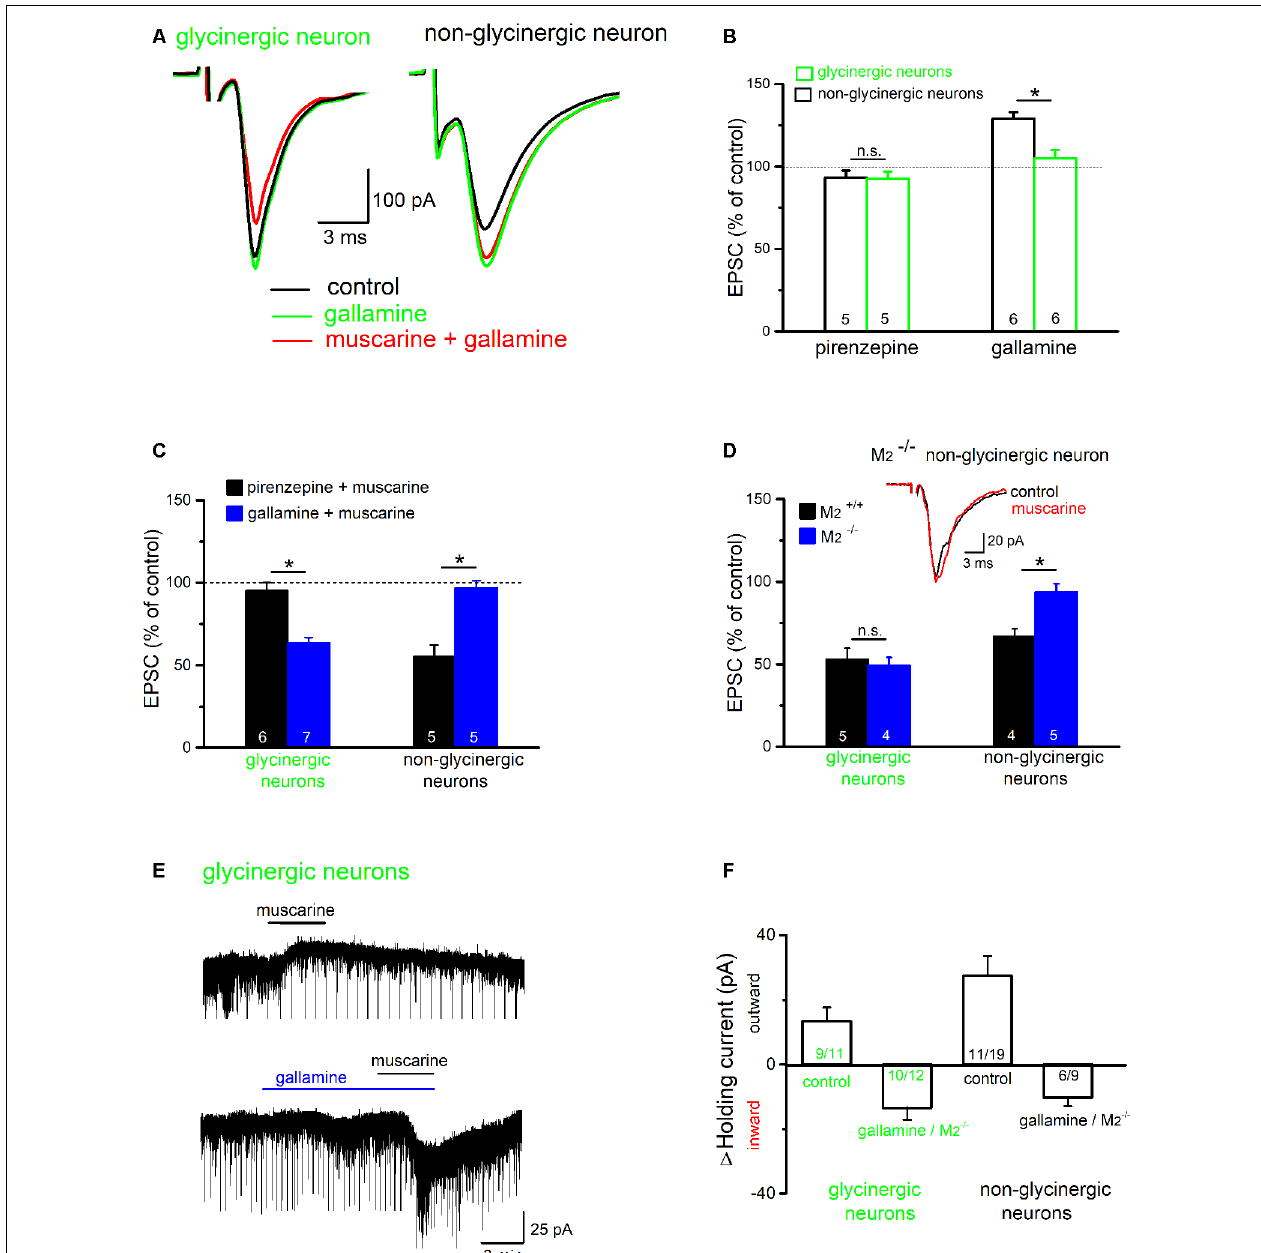
FIGURE 10 | Muscarine exerts a receptor subtype-specific control over excitatory synaptic input onto preBötC neurons. (A) Superimposed traces show the effects of the M 2 R blocker gallamine (20 µ M) on evoked EPSCs in representative traces from both groups of neurons. Gallamine increased EPSC amplitude and blocked the effect of muscarine (10 µ M) in the non-glycinergic neuron (right), but not in the glycinergic neuron (left). (B) Histogram summarizes the relative changes in EPSC amplitudes compared to control (amplitude of control EPSC was set to 100%) in response to the application of the M 1 R antagonist pirenzepine (1 µ M) or the M 2 R antagonist gallamine. Note that an endogenous M 2 R-mediated tonic inhibition was only observed for EPSCs recorded in non-glycinergic neurons. (C,D) Histograms summarize the receptor subtype selectivity of muscarinic modulation of EPSCs in preBötC neurons. Muscarine was applied in the presence of muscarinic acetylcholine receptor (mAChR) antagonists (C) or to slices from M 2 knockout mice (M 2 − / − ) and their wild-type littermates (M 2 + / + ; D ). EPSC amplitude before muscarine application served as control and was set to 100%. Superimposed traces (inset in D ) from an M 2 − / − slice shows that muscarinic inhibition of EPSC amplitude in non-glycinergic neurons is M 2 R-mediated. (E) Muscarinic effects on holding current in glycinergic neurons voltage-clamped at − 70 mV. The application of muscarine produced an outward current (upper trace). In the presence of gallamine, we observed an inward current response to muscarine (lower trace). The downward events along the traces are the simultaneously recorded evoked/spontaneous EPSCs. The histogram in (F) summarizes shifts in holding current for glycinergic and non-glycinergic neurons under control conditions and with M 2 Rs pharmacologically blocked (gallamine) or genetically disrupted (M 2 − / − ). The numbers in columns indicate sample number in each group ( ∗ p < 0.05, n.s. not significant).